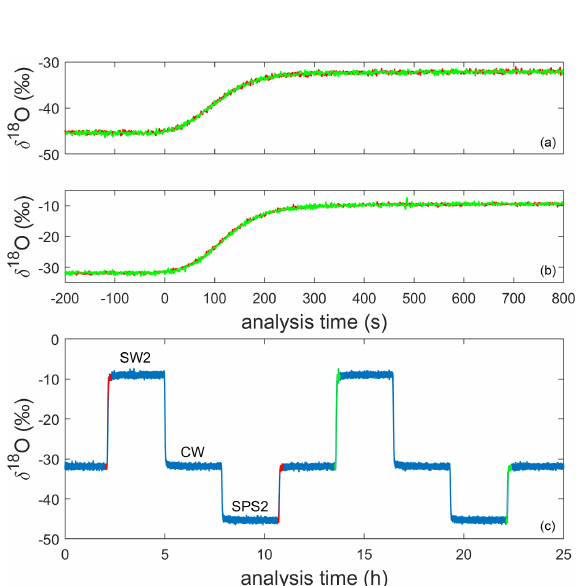
Figure 2. Uncalibrated 1Hz measurements of δ 18 O for the alternat- ing sequence of reference waters during a full analysis day (c) . The 200s preceding and 800s following four reference water transitions are shown in the other panels; two transitions (shown in orange and green) from SPS2 to CW are stacked in panel (a) and two transitions from CW to SW2 are stacked in panel (b)